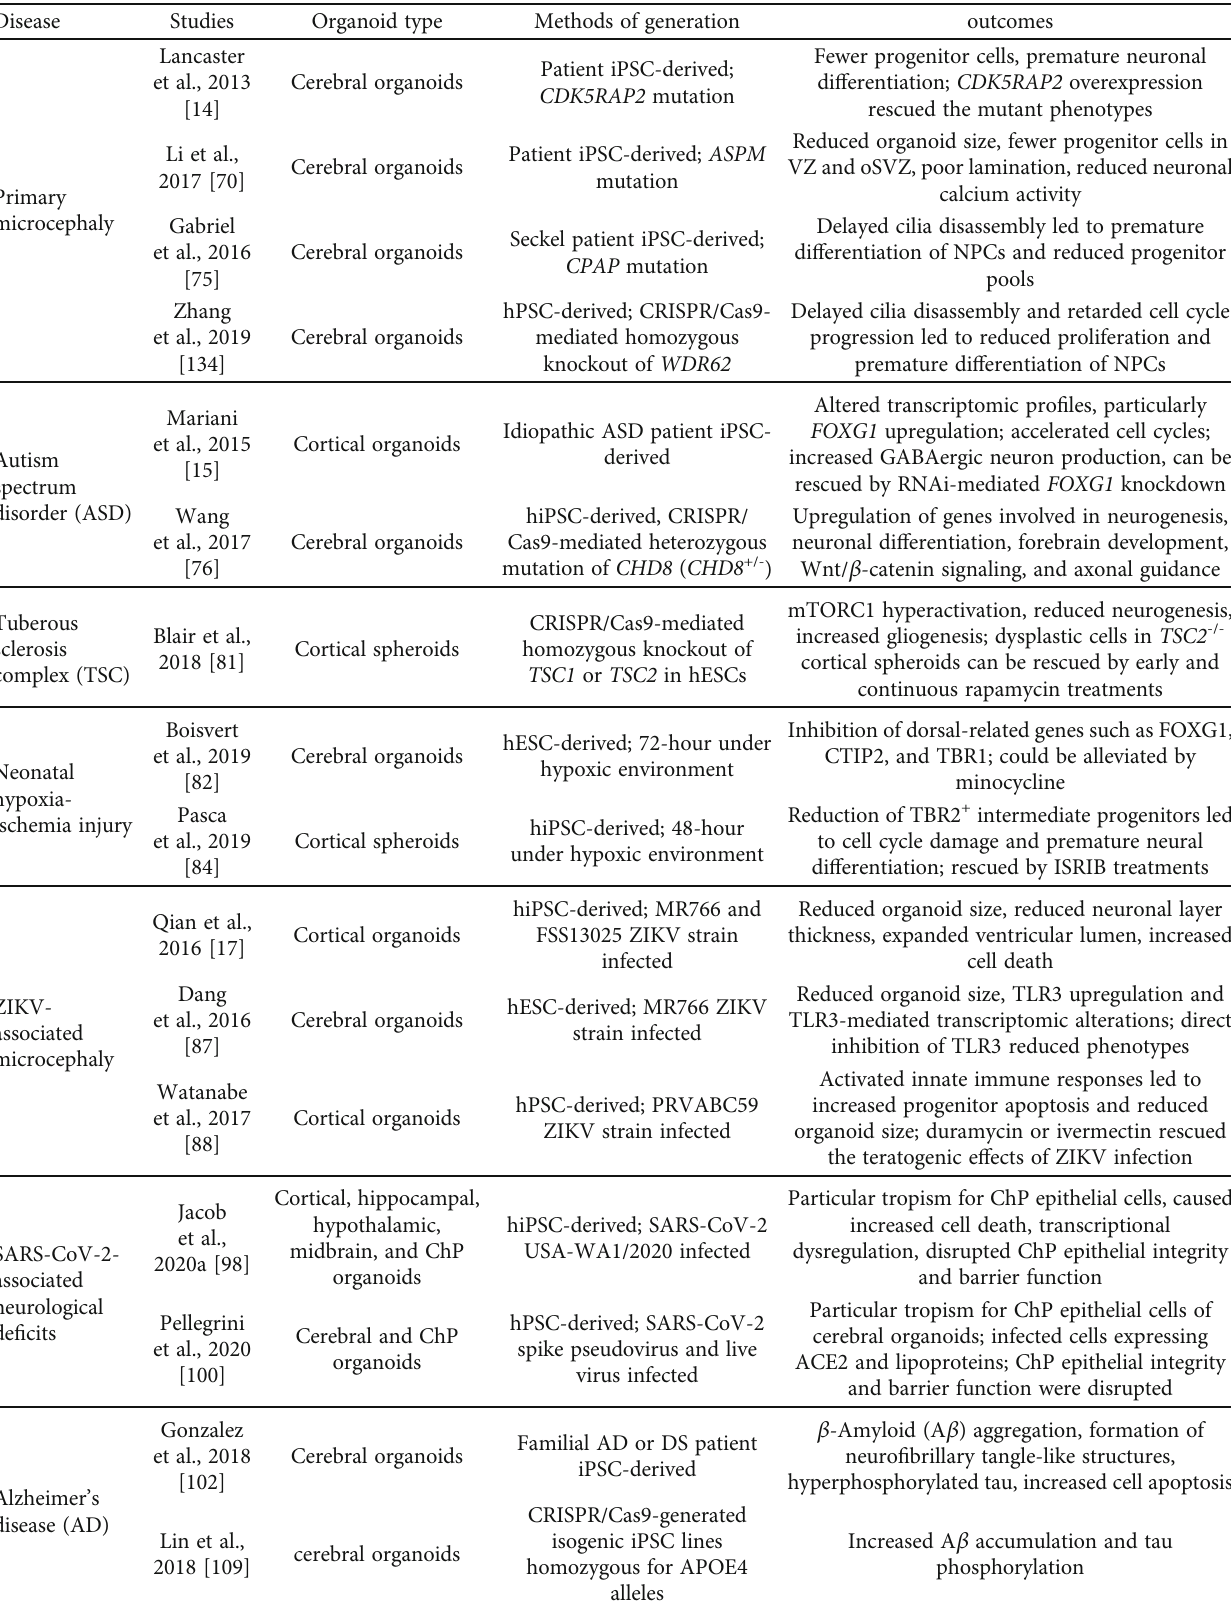
Table 1: Selected studies investigating neurological disorders/de fi cits using human brain organoids.